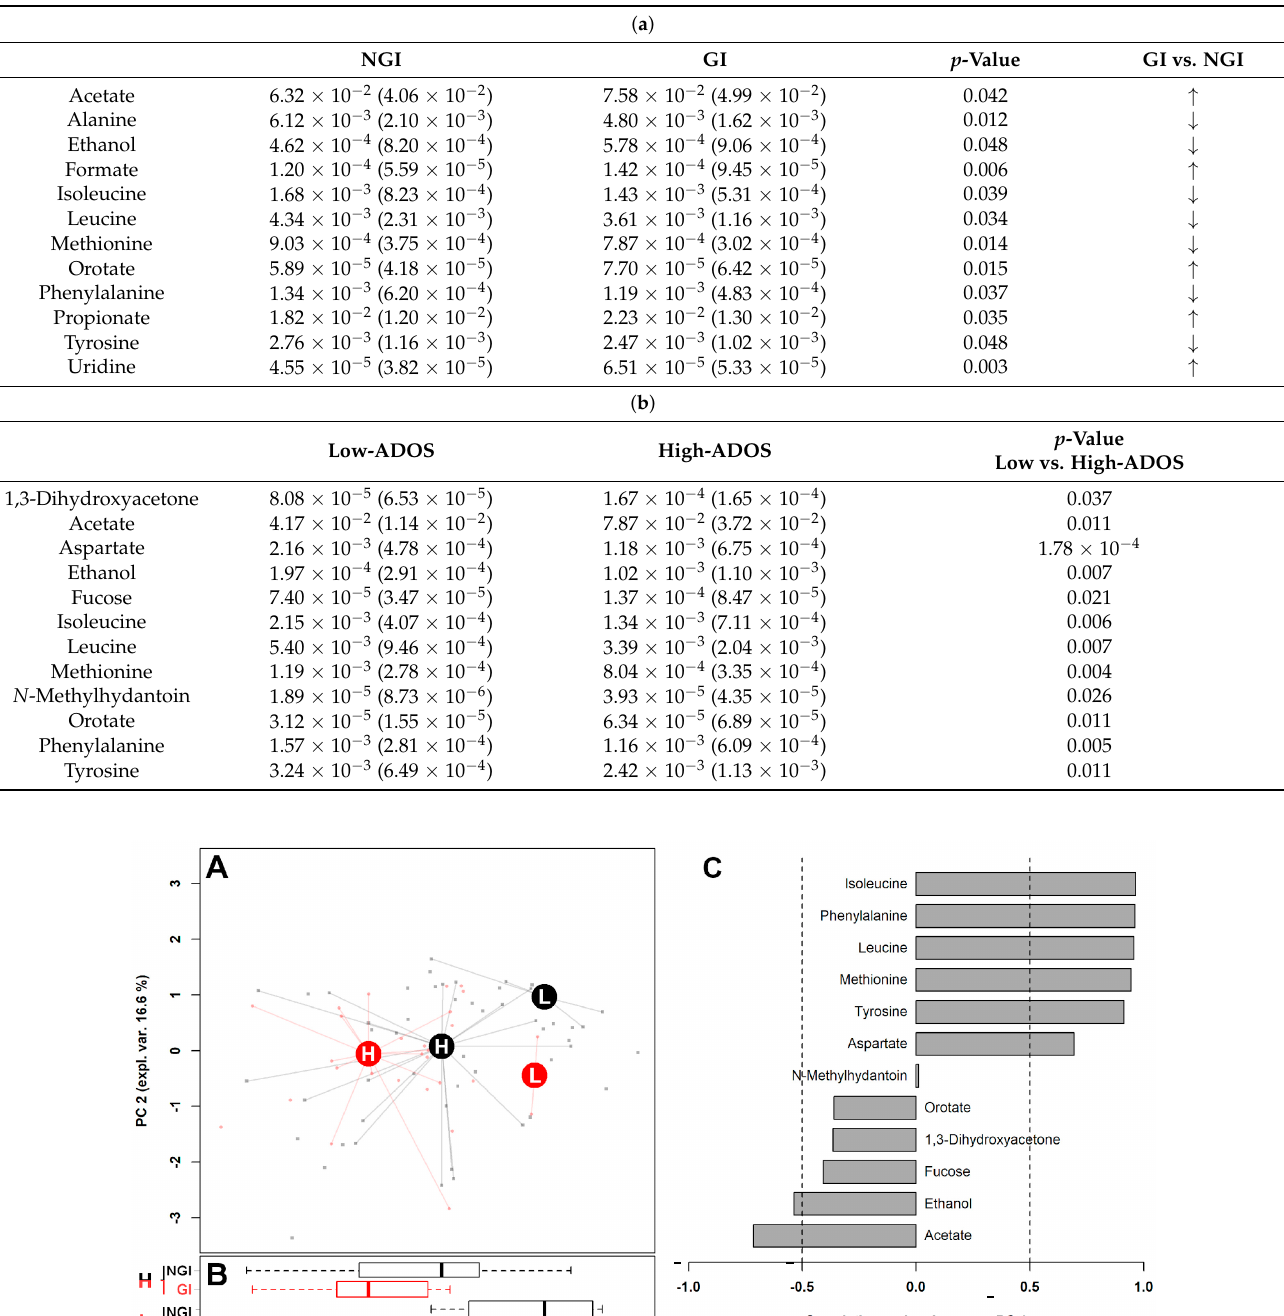
Table 1. Concentration (mmol/L; median (IQR)) in feces of the molecules significantly different between children ( a ) without (NGI) and with gastrointestinal symptoms (GI); ( b ) with high and low autism diagnostic observation schedule (ADOS) scores. Legend: ↑ higher; ↓ lower.